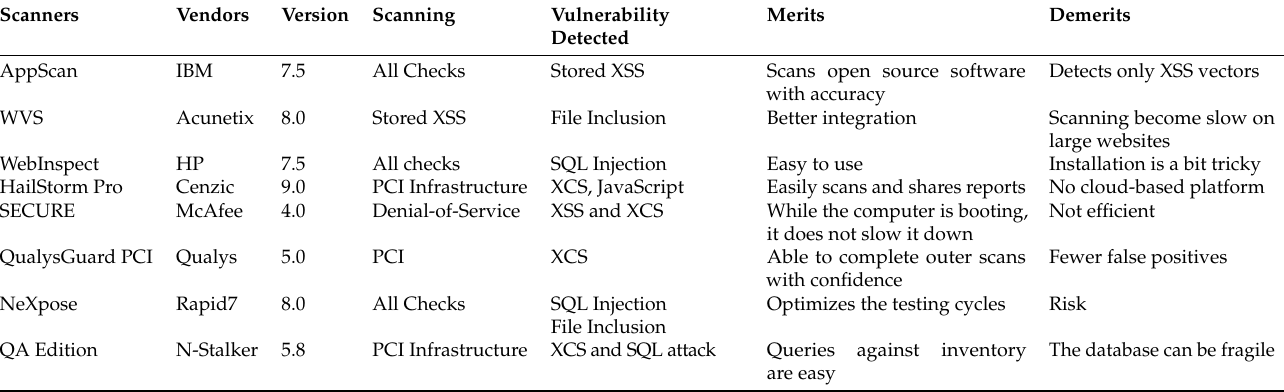
Table 4. Report of scanners with merits and demerits.